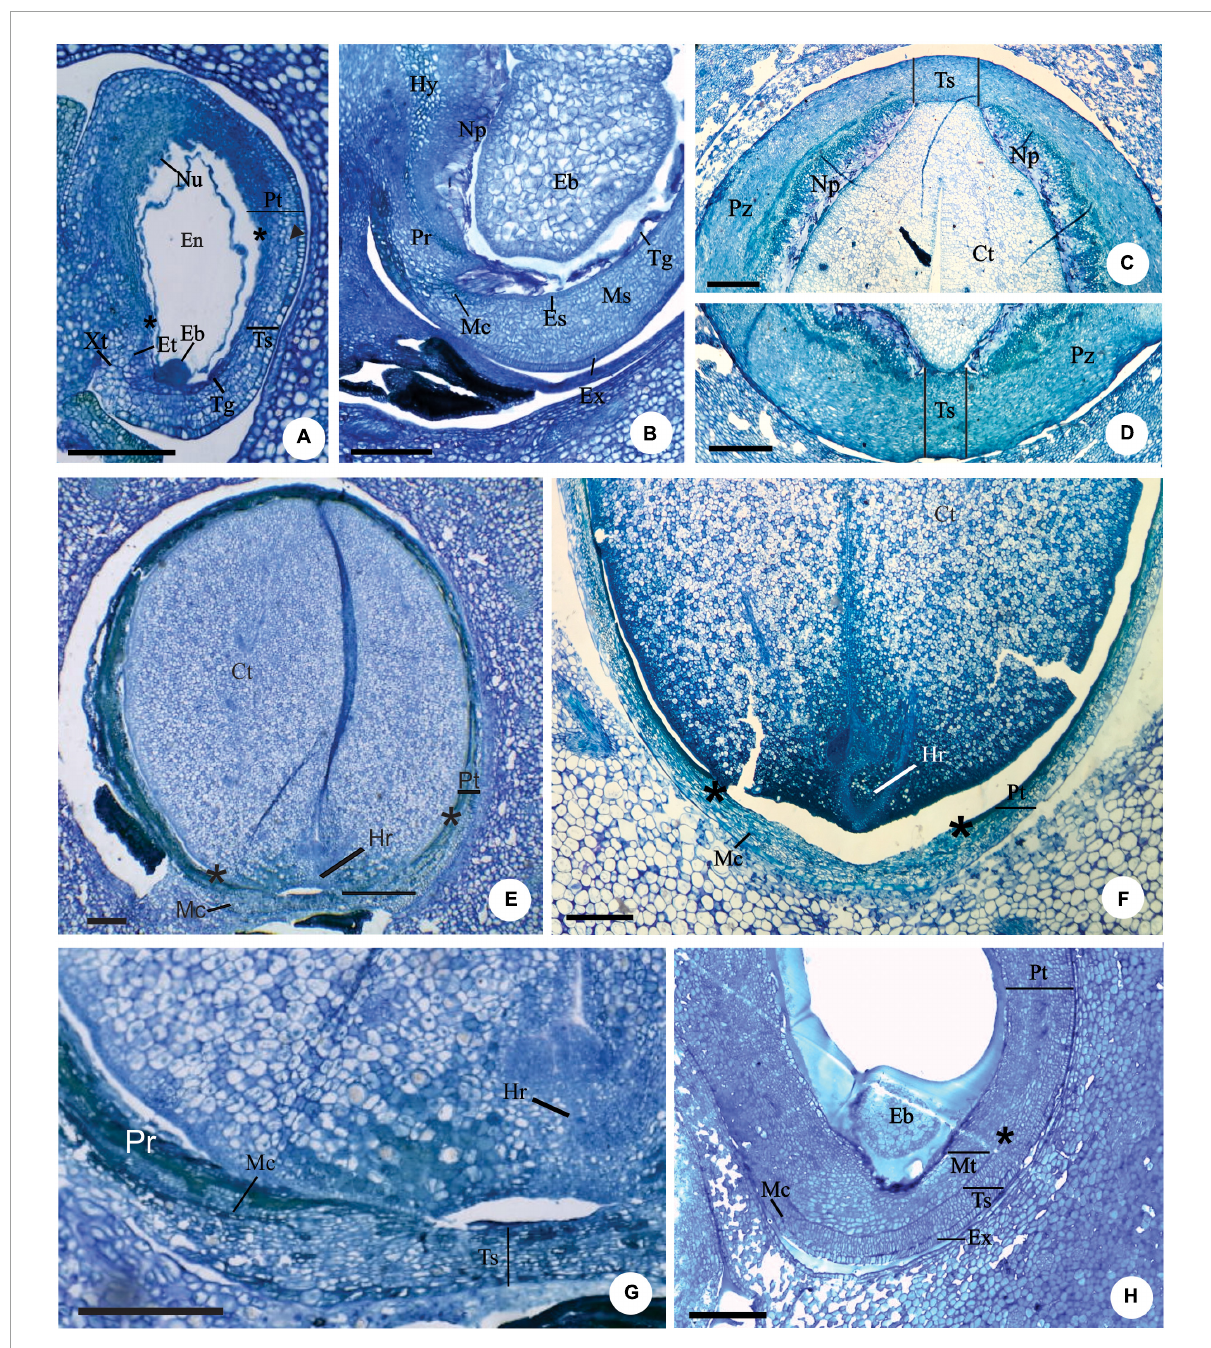
FIGURE2 Longitudinal (A,B,E–H) and transversal (C,D) sections of developing (A,B,H) and mature seeds (C–G) of Eugenia longipedunculata (A,E,G) , E. paracatuana (B) , E. gracillima (C,D) , E. involucrata (F) and E. pyriformis (H) . (A) General aspect. Note the non-linear micropylar channel, the nuclear endosperm, the remains of the nucellus, the anticlinal divisions ( (cid:73) ) in the anti-raphe and the limit of the pachychalaza (*). (B) Detail evidencing the hypostase, proliferating nucellus, radially elongated exotestal and endotestal cells and mesotesta with divisions in various planes. (C,D) Detail showing the perichalazal integument. (E,F) General aspect of the markedly campylotropous seed. Note the eugenioid embryo occupying the seed cavity and the limit of the pachychalaza (*). (G) Detail of the micropylar region. (H) Detail evidencing the multiplicative tegmen and exotesta constituted by radially elongated cells in vicinity of the micropyle. Eb, embryo; Et, endostome; En, nuclear endosperm; Es, endotesta; Ex, exotesta; Hy, hypostase; Hr, hypocotyl-radicle axis; Mc, micropylar channel; Ms, mesotesta; Np, nucellus proliferation; Nu, nucellus; Pr, pre-raphe; Pt, pachychalazal integument; Pz, perichalaza; Tg, tegmen; Tp, multiplicative tegmen; Ts, testa; Xt, exostome. Scale bars = 200 µ m (A,B,E–H) , 500 µ m (C,D)